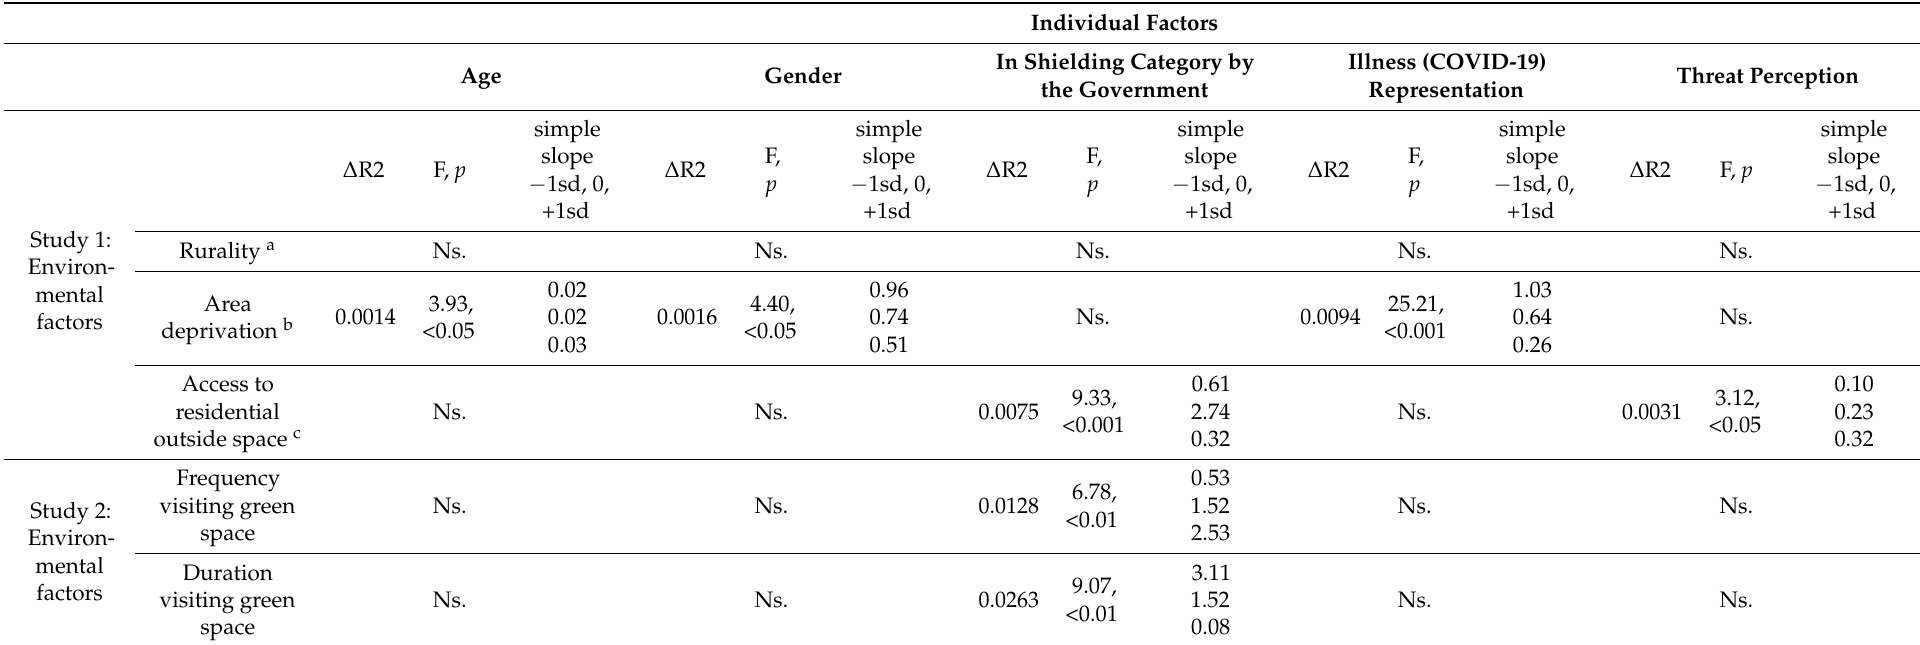
Table 3. Moderation of individual demographics and illness beliefs by environmental